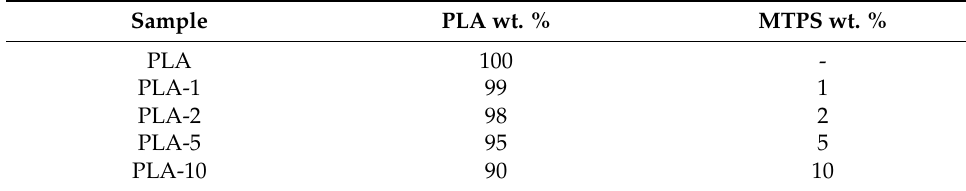
Table 2. Sample name and composition.